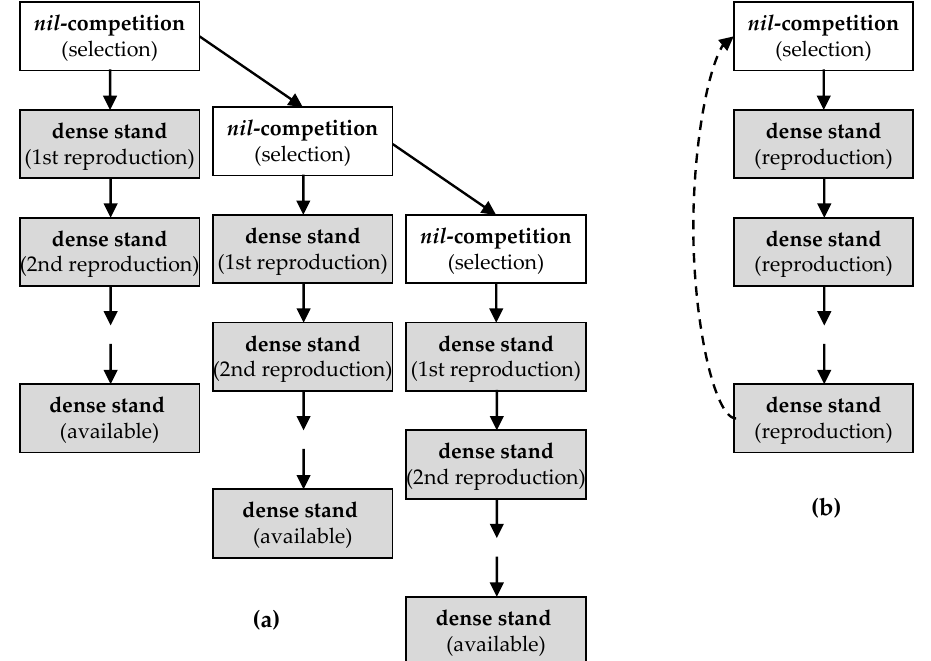
Figure 4. Each multiplication round comprises a first starting phase of bulk breeding under nil -competition conditions followed by seed reproduction under dense stand conditions for the number of seasons required to satisfy the farmer’s demands. The procedure is ( a ) continuously suggested for landraces widely adopted and/or suffering from seed-borne diseases; or ( b ) suggested on a periodic basis with frequency depending on species and adoption rate of the